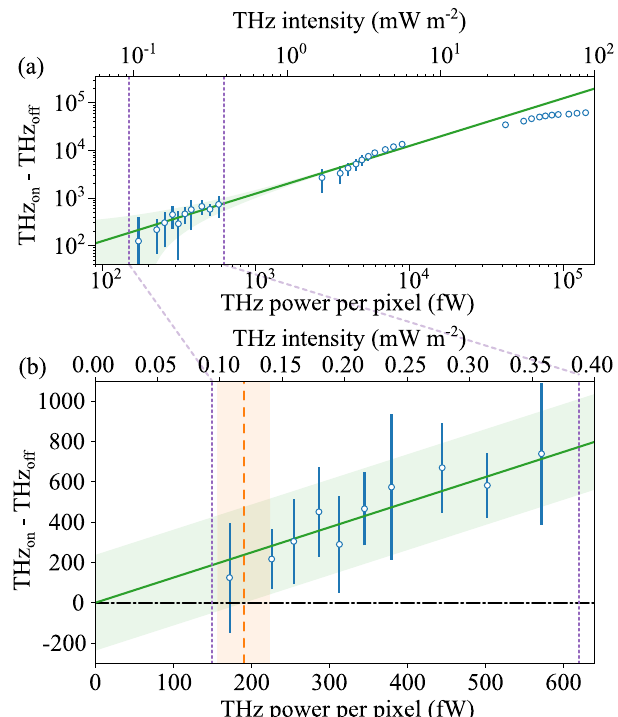
FIG. 4. Minimum detectable power. (a) The fluorescence signal − THz THz (open blue circles) as a function of incident THz on off power for a total integration time of 1 second. The linear trendline is extrapolated from that in panel (b) to highlight the saturation point at THz powers above 20 pW per ð 40 × 40 Þ μ m 2 pixel. The vertical dashed lines highlight the range of the data used in panel (b). (b) Plotting the measured fluorescence signal (open blue circles), we can map the linear response of the system (solid green line) plus its associated uncertainty (green shaded region) to the point at which the fluorescence signal is no longer reli- ably detectable (dashed orange line), at ð 190 (cid:2) 30 Þ fW per ð 40 × 40 Þ μ m 2 pixel for a 1-s integration